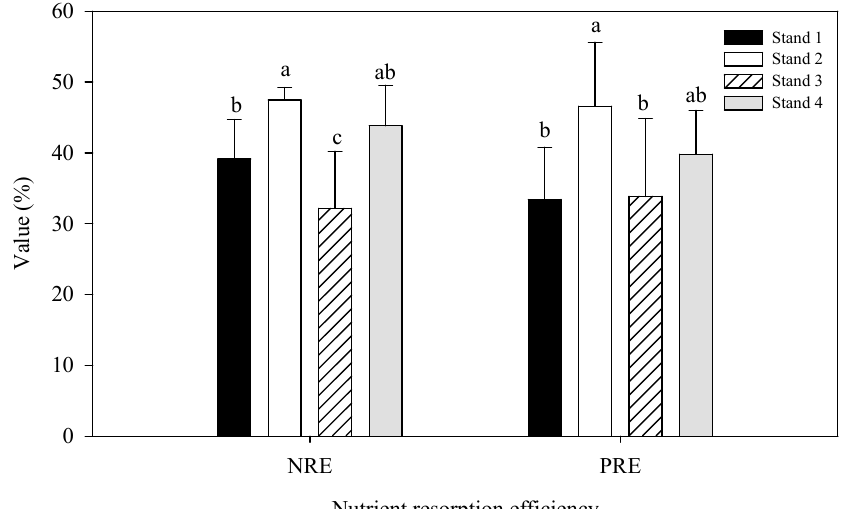
Figure 2. N and P resorption efficiency in four moso bamboo stands. The error bar is the mean value of four samplings (mean ± SD, n = 4), and different lowercase letters indicate significant differences between groups ( p ≤ 0.05).